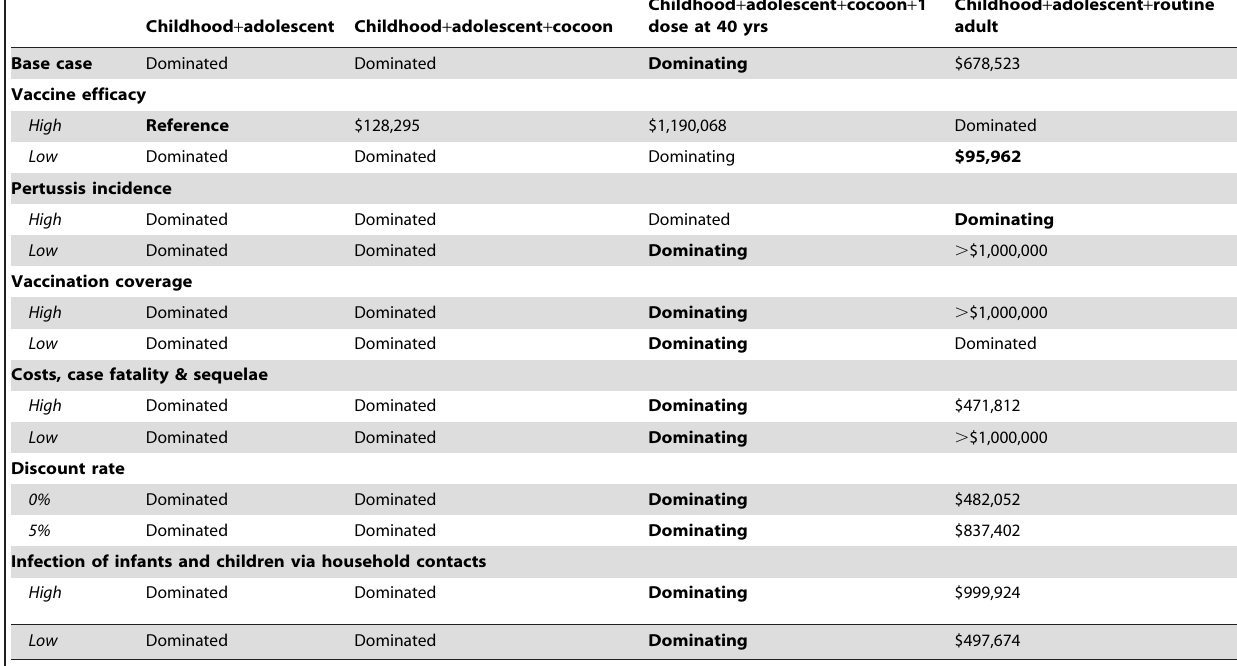
Table 5. Sensitivity analyzes on cost per discounted life year gained at steady